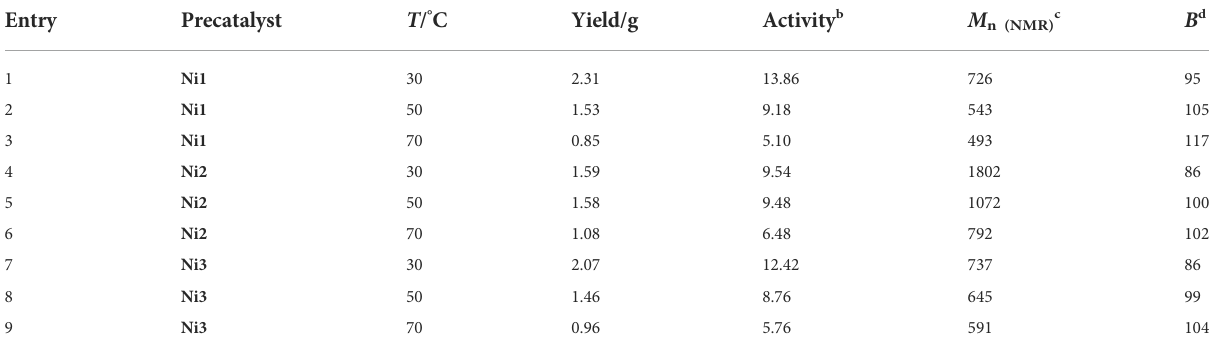
TABLE 1 Ni(II) catalysts for ethylene oligomerization a